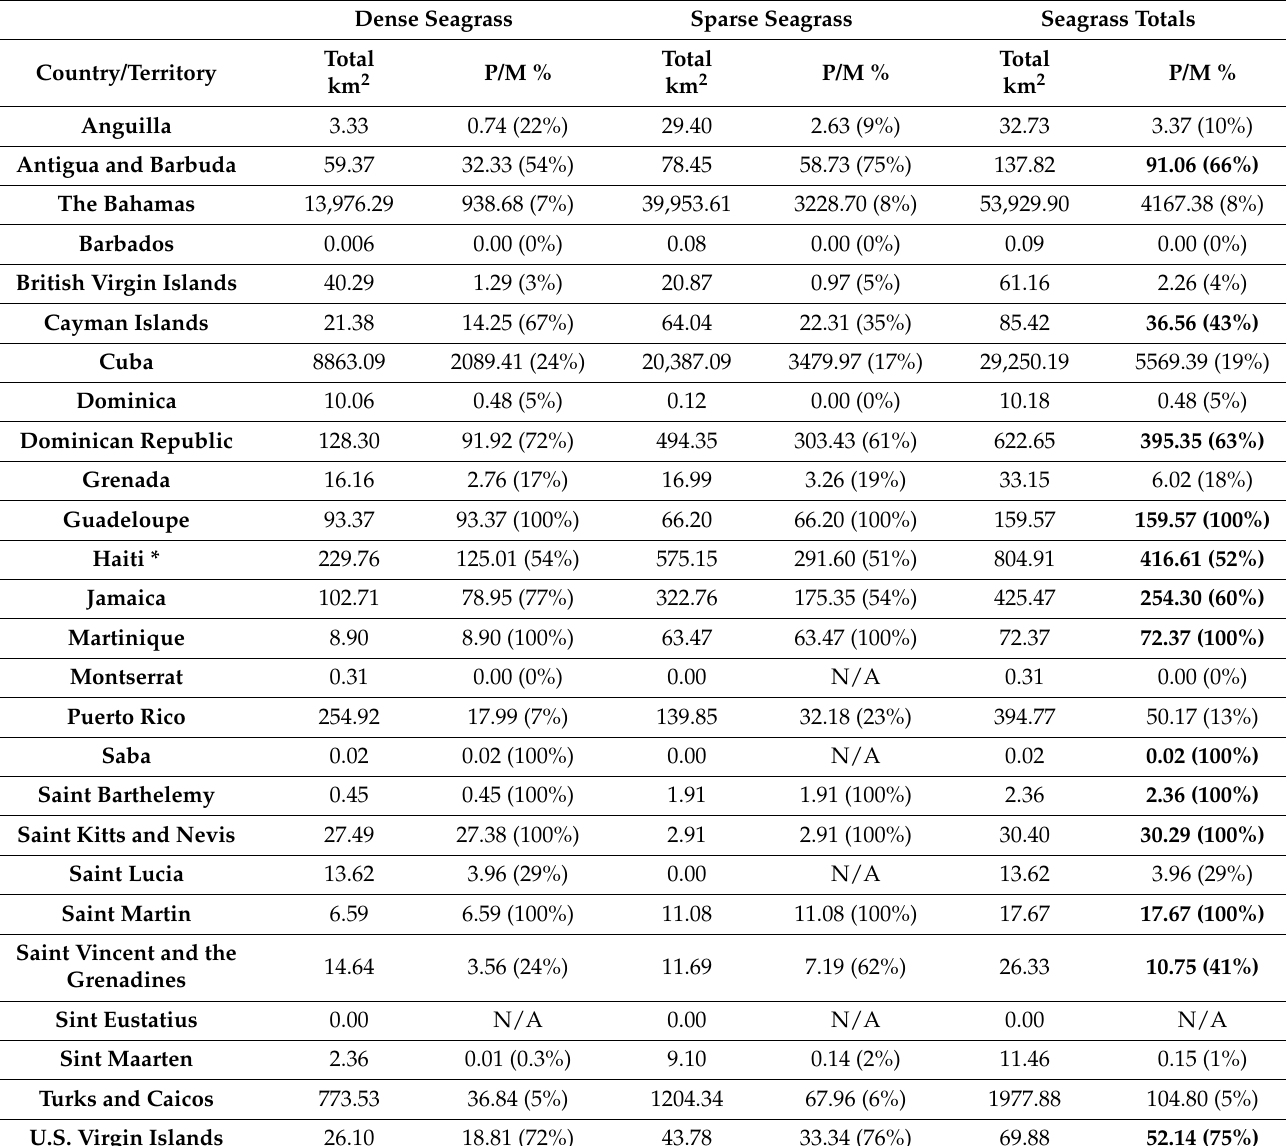
Table 6. Total area (km 2 ) of seagrass benthic habitat classes within the shallow marine zone (<30 m depth) of the Insular Caribbean per EEZ and corresponding area and percentage within declared marine protected and managed areas (P/M %). The total seagrass protection percentages in bold indicate attainment of at least 30%. Dense Seagrass Sparse Seagrass Seagrass